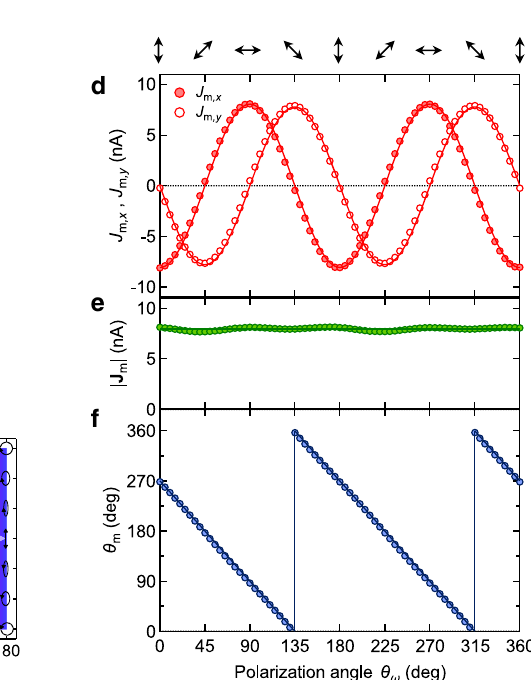
Fig. 2 | Fundamental properties of spin-driven photocurrents. a Schematic of the experimental setup for measuring zero-bias photocurrent J x and Faraday rotation θ F at normal incidence of linearly y -polarized ( θ ω = ε ω =0°) 800nm light. b Laser-intensity dependences of J x for opposite out-of-plane saturation magneti- zations± M z . The lines are linearly fi tted to the data. c Dynamical responses of J x for± M z . The response time is limited to the bandwidth of the instruments used. d , e Out-of-plane magnetic- fi eld dependences of ( d ) J x and ( e ) θ F . The two-step